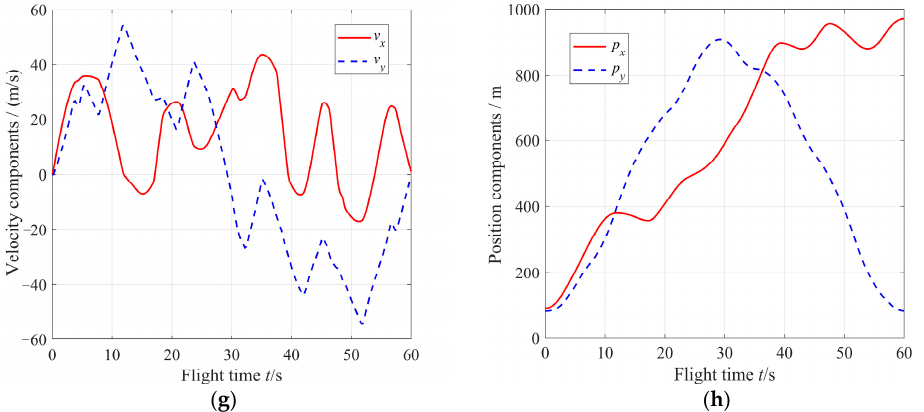
Figure 10. The results of Example 2. ( a ) Optimal trajectory solved by HNSCP, where the blue boxes indicate the full thrust arcs (12 arcs in total). ( b ) Optimal trajectory solved by HNSCP, where the red circles indicate the events when the vehicle appeared close to the obstacle boundary (14 events in total). ( c ) Trajectories obtained by HNSCP algorithm with different iteration numbers. ( d ) Monte Carlo random test trajectories. ( e ) Profiles of thrust acceleration magnitude, where the full thrust arcs have been marked with numbers. ( f ) Profiles of thrust direction. ( g ) Profiles of velocity components. ( h ) Profiles of position components.